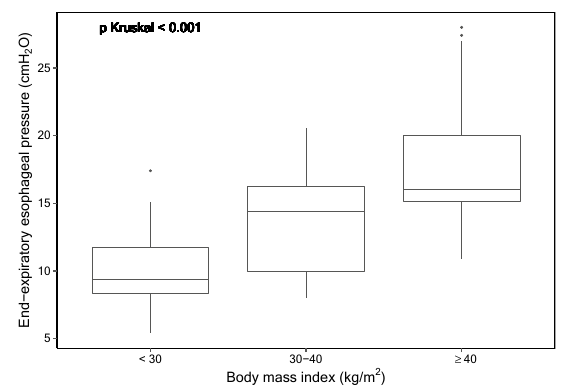
Fig. 1 Relationship between body mass index and end‑expiratory esophageal pressure measured at a set positive end‑expiratory pressure of 5 cmH 2 O